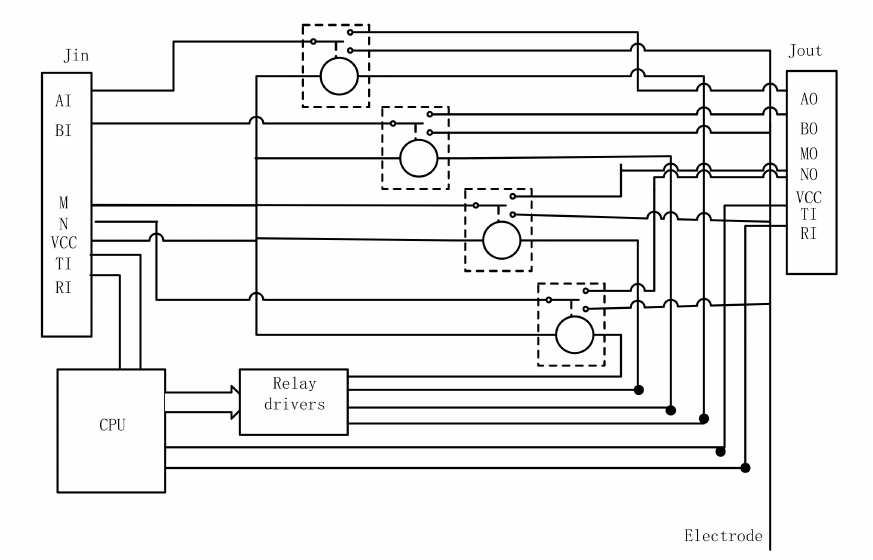
Figure 3. Circuit schematic for one electrode connection in the ESD, designed by Zheng Cai-Jun